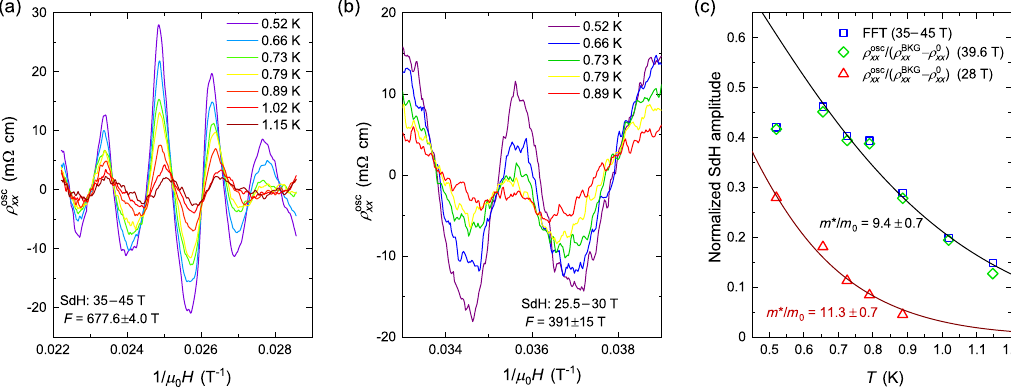
FIG. 5. The amplitude of the oscillatory component of resistivity ρ osc at various temperatures in the field ranges (a) 35 ≤ μ 0 H ≤ 45 T xx H Þ curves shown in Fig. 4(c). The and (b) 25 . 5 ≤ μ 0 H ≤ 30 T. ρ osc is obtained by background subtraction of a polynomial from the ρ xx xx ð oscillation frequencies are mentioned in each panel. Note that for the field range displayed in (a), the oscillations have a single frequency which is supported by the dHvA measurements (see Supplemental Material, Figs. 1(a) and 1(b) [93]). (c) Lifshitz-Kosevich fits of the T dependence of ρ osc shown in (a) (green diamonds) and (b) (red triangles) normalized by the power-law T -dependent background xx resistivity (see Sec. V C for details). The temperature dependence of the FFT peak height (the FFT is performed after normalizing ρ osc xx by the background resistivity) of the oscillations shown in (a) (blue squares) is consistent with that of normalized ρ osc . All data are xx measured on sample